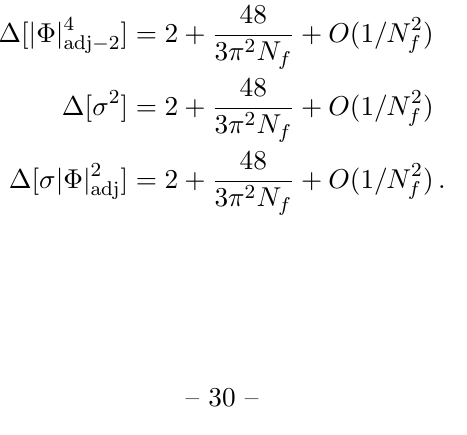
operator renormalization. Dashed line stands for e(cid:11)ective (cid:27) (cid:12)eld adj